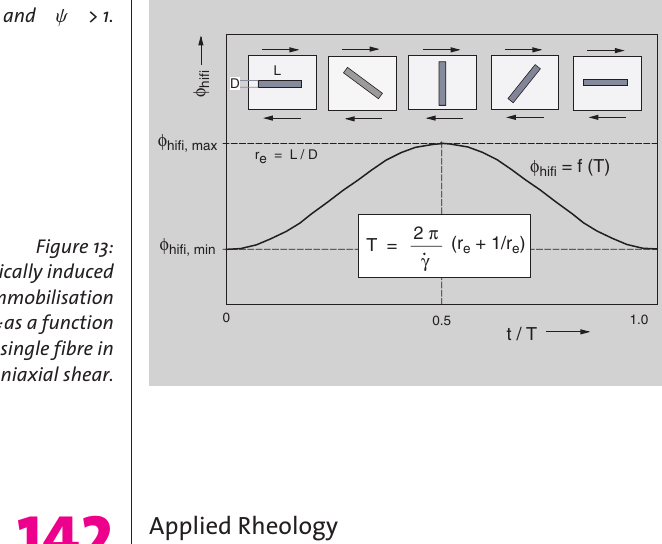
Hydrodynamically induced fluid immobilisation fraction f hifias a function of time for single fibre in uniaxial